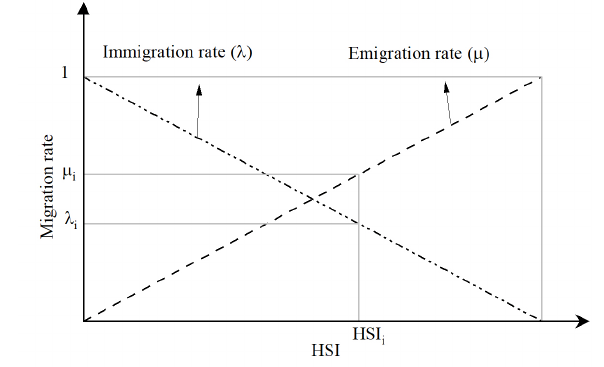
Fig. 5. Migration curve of the BBO algorithm